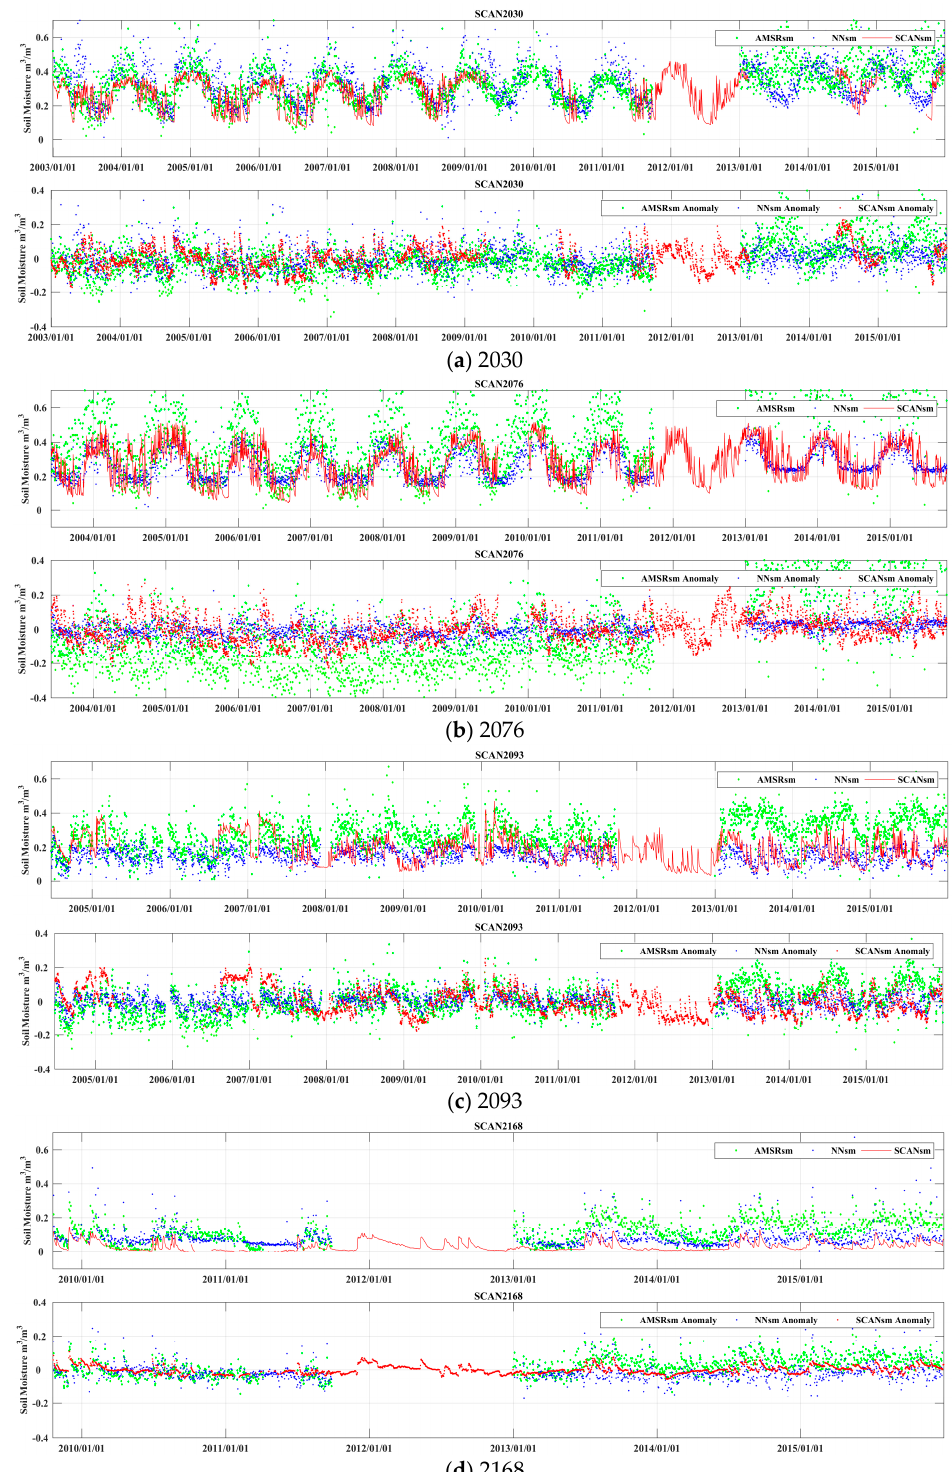
Figure 10. Time series (upper panel) and anomaly time series (lower panel) for SCANsm (red line), NNsm (blue dots) and AMSR_LPRM (green diamonds) over the long time period (2003–2015) in sites: ( a ) 2030; ( b ) 2076; ( c ) 2093; and ( d ) 2168.